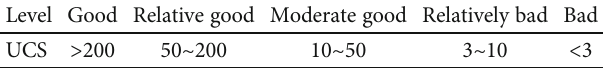
Table 2: UCS classi fi cation for columnar jointed rock